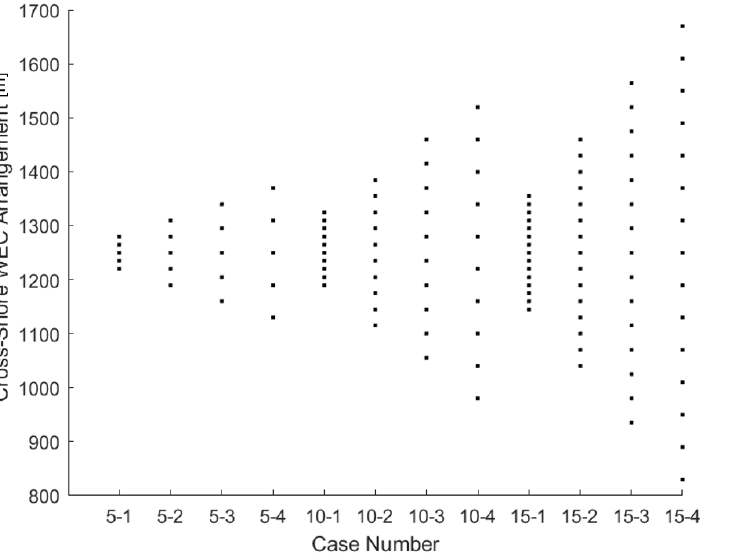
Figure 11. The spatial arrangement of the WEC arrays for each case study. The x-label describes the number of WECs, and the number of widths spacing between each WEC. Each spacing is 18 m long; therefore, five WECs spaced at 18 m (1 WEC width spacing) are labeled